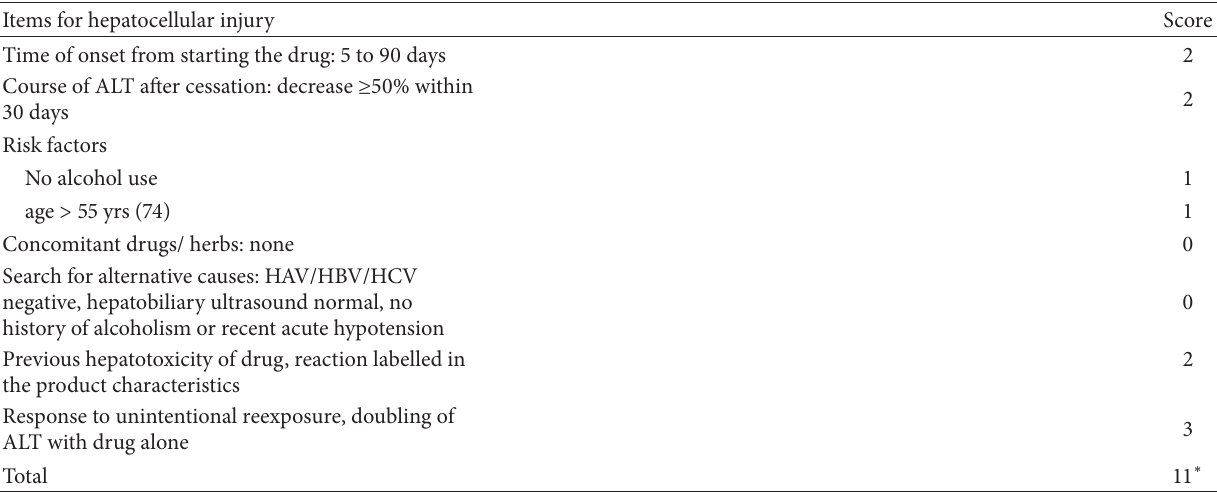
Table 1: Updated RUCAM results for irbesartan.